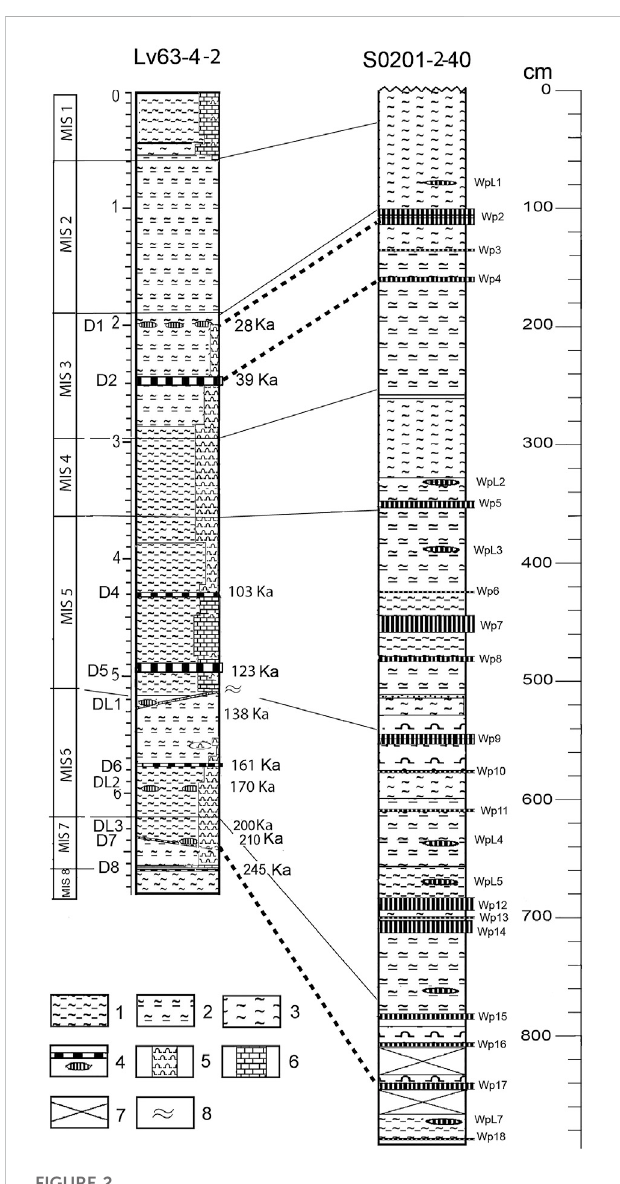
FIGURE 2 General view of cores Lv63-4-2 and So201-2-40 with elements of the tephrostratigraphic correlation. 1-3 granulometric composition of sediments: 1 – clayey silts; 2 – silty clays; 3 – clays; 4 – tephra layers and lenses;5 – diatom-richsediments;6 – carbonate-bearingsediments (coccolithic-foraminiferal); 7 – identi fi ed non-sequences; 8 – core breaks (b1, b2 – no sediment). The numbers to the right of core Lv63-4-2 show the age of the tephra layers. Thin straight lines characterize the age correlation of the cores (MIS1-MIS7). The bold dashed lines show the correlation of the cores with respect to the tephra